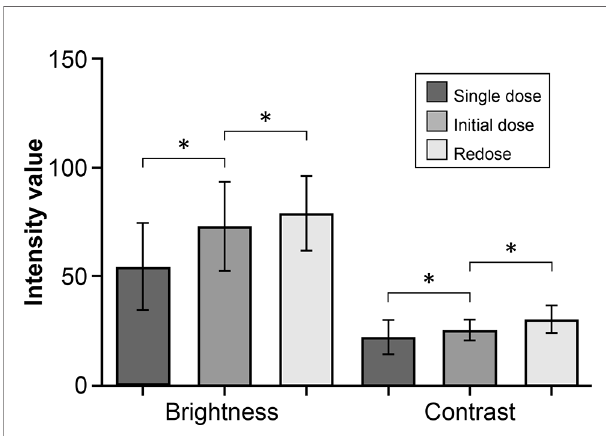
FIGURE 1 | Bar plot showing a comparison of the mean (SD) intensity modalities in the fl uorescein sodium redose, initial-dose, and single-dose groups. The top and bottom whisker marks indicate the SD. *P < 0.001. The mean (SD) values of brightness and contrast of images are 79.1 (17.2) and 30.5 (6.3), respectively, in the redose group; 73.1 (20.4) and 25.4 (4.9) in the initial-dose group; and 54.6 (20.0) and 22.2 (7.9) in the single-dose group. The values are reported in units of optical density de fi ned by Fiji open-source analytic software. Brightness is the mean gray value, calculated by the sum of the gray values of all the pixels in the selection divided by the number of pixels. Contrast is the SD of gray values used to generate the mean. SD, standard deviation. Used with permission from Barrow Neurological Institute, Phoenix,